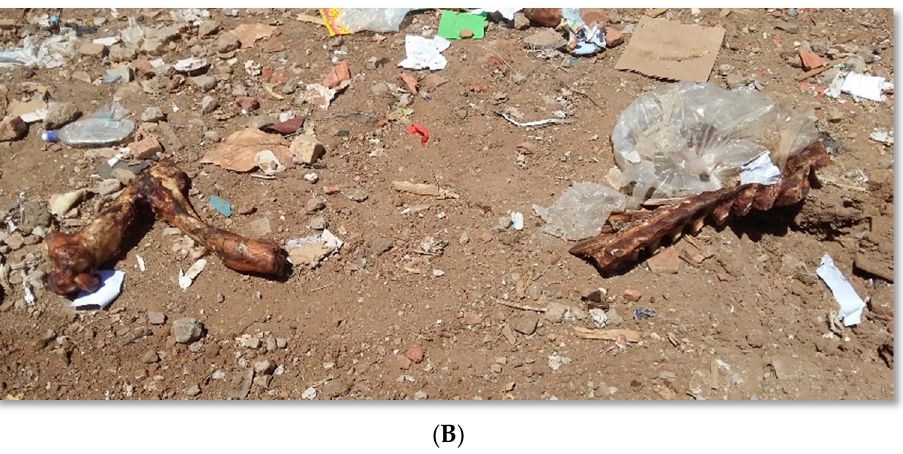
Figure 6. Chicken meat ( A ) and beef carcasses ( B ) discarded on landfills. Source: Authors.